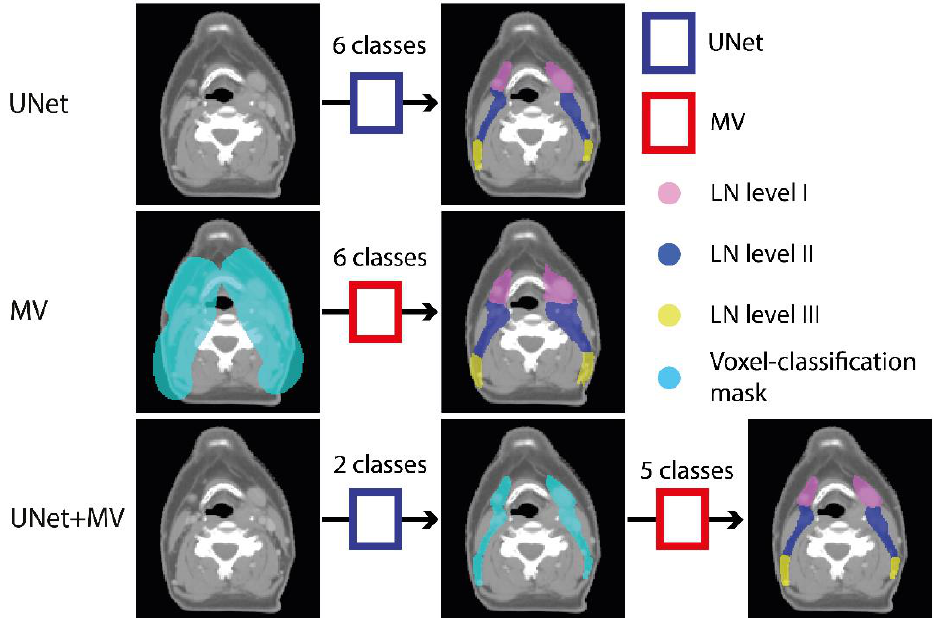
Figure 1. Schematic overview of the experimental outline. UNet (blue boxes) and MV (red boxes) were used to make three model configurations. In the first configuration, a patch-based UNet segments the background and LN levels I–V directly from the planning CT. In the second configuration, MV classifies the background and LN levels I–V voxels from within a preconstructed mask (cyan). In UNet+MV, a patch-based UNet first segments the combined structure of LN levels I–V. This is subsequently used as a mask (cyan) for MV to subsequently classify positive voxels into individual levels I–V. The details of both models are given in Figure 2. Abbreviations: MV: multi-view; CT: computed tomography.(Also shows in Figure S2).